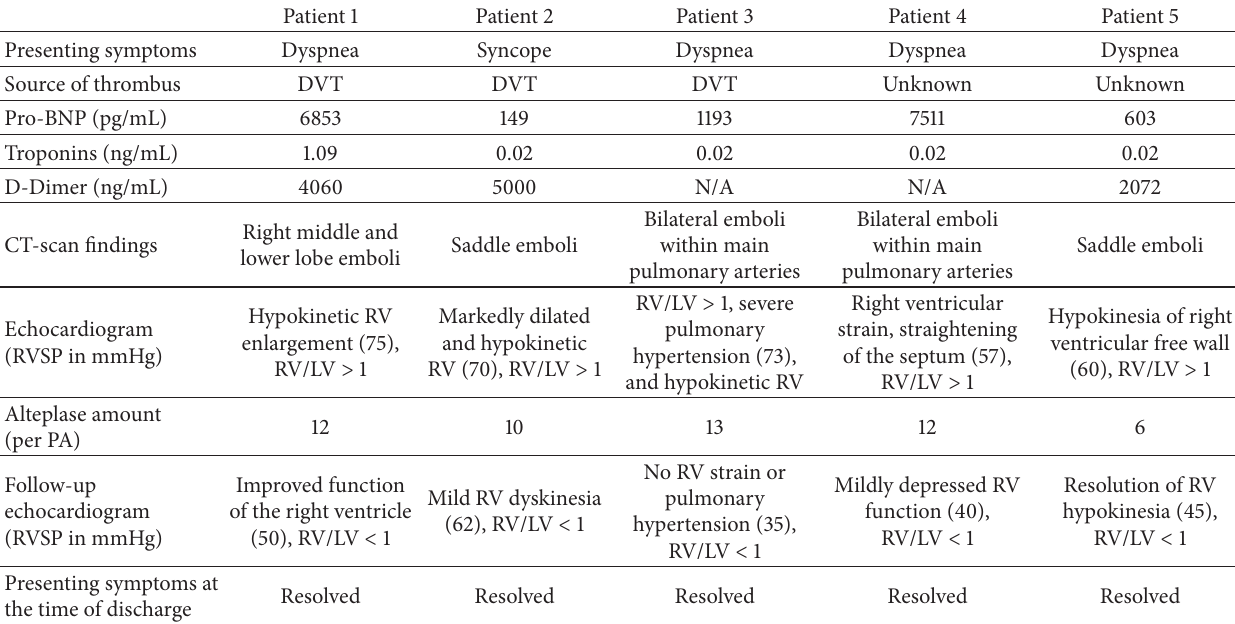
Table 1: Summary of the patients’ data.